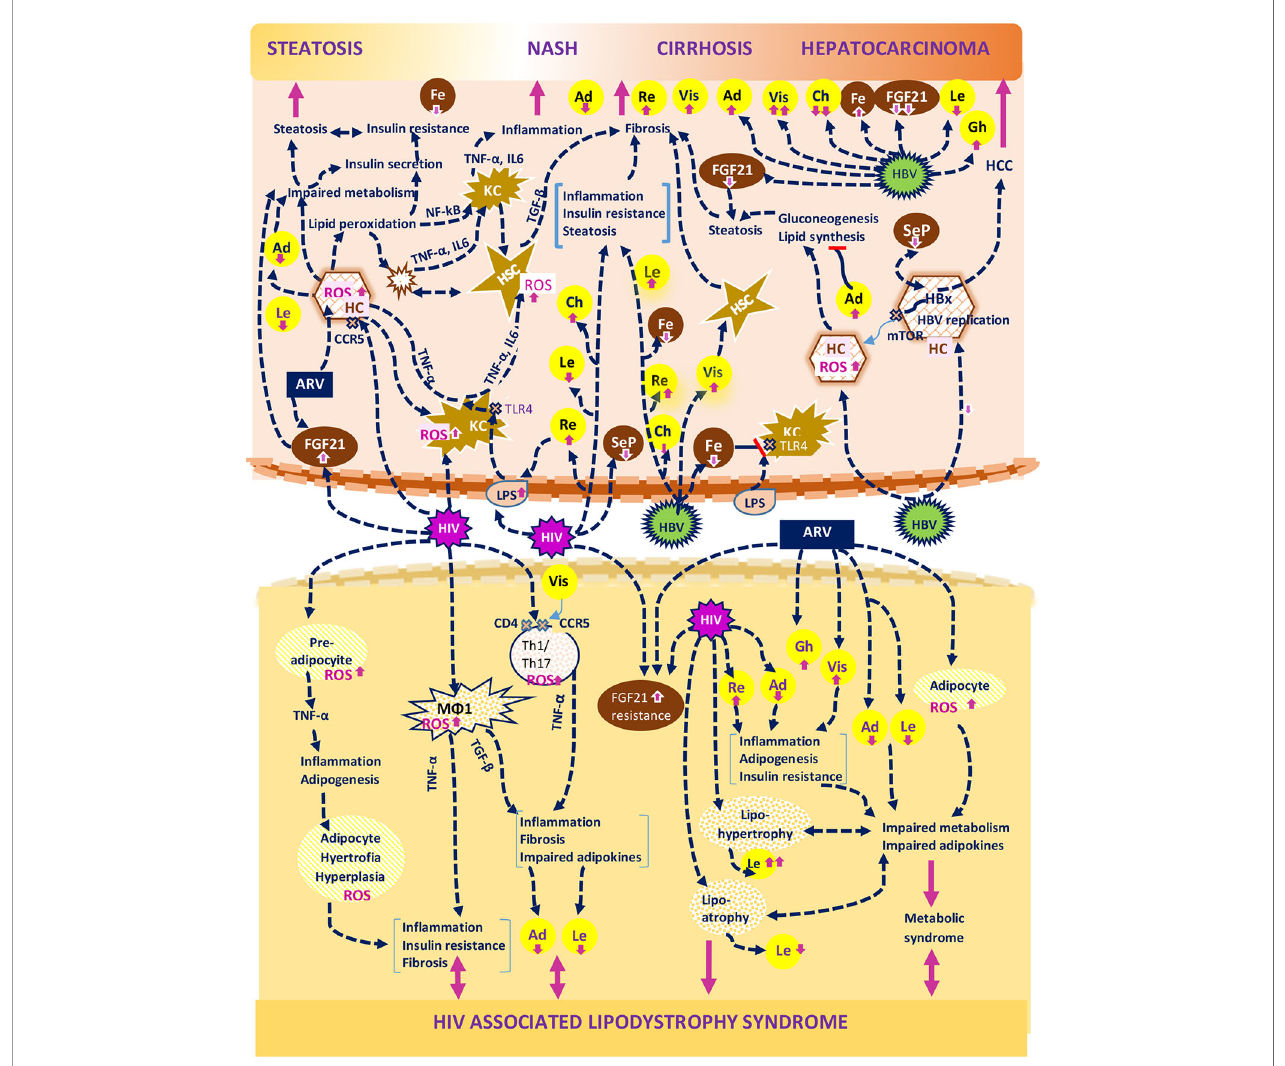
FIGURE 2 | A brief representation of metabolic and in fl ammatory mechanisms generated by HIV and HBV infections and their interference with the hepatokine/ adipokine axis during the progression of non-alcoholic fatty liver disease. The fi gure shows: a. The effects of HIV on parenchymal liver cells: activation of CCR5 receptors of hepatocytes; the release of reactive oxygen species (ROS) and their subsequent effect on metabolic alterations inducing hepatic steatosis and non- alcoholic steatohepatitis (NASH). ROS excess also promotes lipid peroxidation and hepatocyte necrosis, which in turn aggravate liver in fl ammation and fi brosis either directly, through proin fl ammatory cytokines (TNF- a , IL6) and pro fi brogenic cytokines (TGF- b ) or indirectly, through the ensuing proin fl ammatory and pro fi brotic response. b. The effects of HIV on non-parenchymal liver cells: both Kuppfer cells (KCs) and hepatic stellate cells (HSCs) can be regulated by HIV directly and indirectly via endotoxins (LPS), leading to the progression of the in fl ammatory response and fi brosis. c. The effects of HIV on adipose tissue cells: HIV ensures the transformation of these cells in cells with pro-in fl ammatory properties (adipocyte and preadipocyte cells, Th1/Th17-CD4ly lymphocytes and macrophages-M F 1); HIV also promotes a disproportionate release of hepatokines and adipokines which in turn lead to liver in fl ammation, adipogenesis, insulin resistance and ultimately to HALS. d. The actions of HBV on hepatocytes: the induction of ROS with metabolic consequences; the changes in the concentrations belonging to hepatokines that promote fi brogenesis and hepatocellular carcinoma (HCC); the decreasing concentration of the protective hepatokine FGF21; the activation of mTOR, a metabolic receptor, stimulated by HBV protein x (HBx) e. The effect of antiretrovirals (ARVs) on the adipose tissue: ARVs favor the release of adipokines with lipogenetic role (e.g. resistin) and the reduction of anti-adipogenic adipokines (e.g. adiponectin, and leptin) f. The impact of HIV and ARVs on the occurrence of a speci fi c metabolic syndrome, namely HIV/ARV associated lypodistrophy syndrome (HALS). HALS arises as a result of HIV-associated in fl ammatory changes and ARV-related impact on adipogenesis and is mediated by multiple mechanisms (adipocytes hypertrophy or atrophy, the evolution of the metabolic syndrome and the imbalance of hepatokine adipokine axis). Organokines synthesized predominantly in the liver are presented in brown and those synthesized predominantly in the adipose tissue are presented in yellow. The aggravating actions for the liver and adipose tissue are shown in pink. HC, hepatic cells; KC, Kupfer cells; HSC, hepatic stellate cells; ARV, antiretrovirals; M f , macrophage; ROS, reactive oxygen species; HBx, hepatitis B virus X protein; Vis, visfatin; Re, resistin; Fe, fetuin; Le, leptin; Ch, chemerin; Ad, adiponectin; Gh, ghrelin; SeP, selenoprotein; Re, resistin; Th, T helper lymphocyte; LPS, endotoxin; receptor; apoptotic cells; TLR4, Toll-like receptor